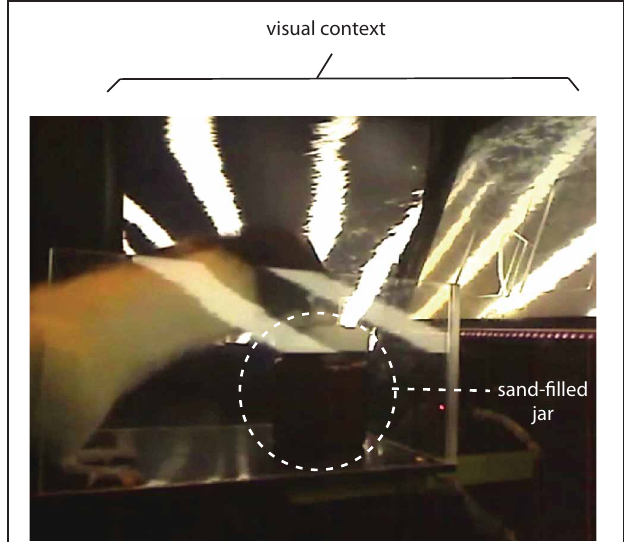
FIGURE 5 | A contextual response-selection task. The rat is required to either dig the sand in the sand-filled jar or push the jar to obtain a piece of cereal. The behavior selection is associated with the visual context presented in the background using an array of three LCD monitors (partially shown